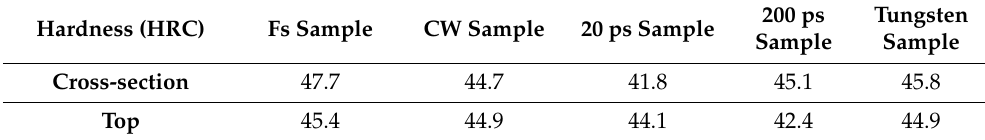
Figure 17. Average grain size area as a function of pulse width (Adapted from reference [44]). Table 6. Hardness values for the tungsten sample processed with different lasers [44]. Hardness